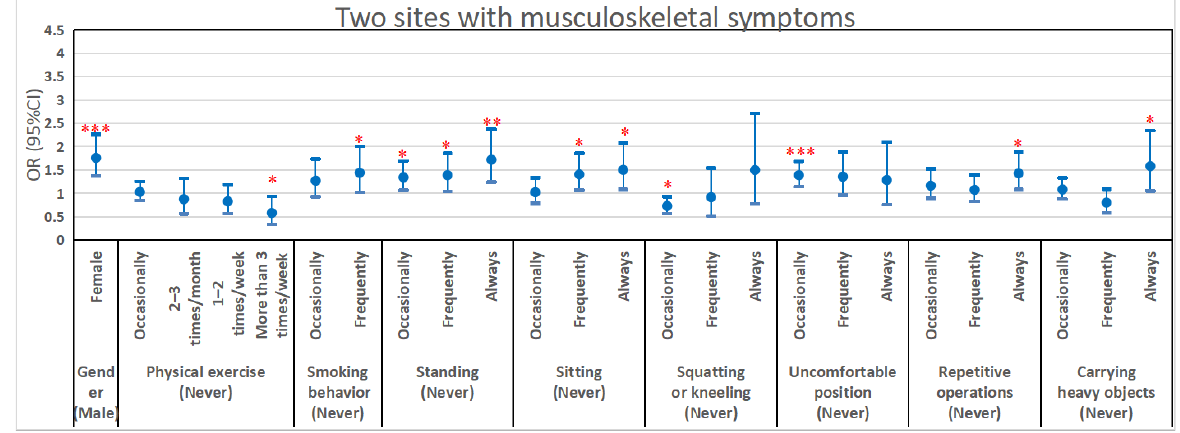
Table 3. PR value of the musculoskeletal symptoms of different body sites in the past 12 months. ( n = 2116).